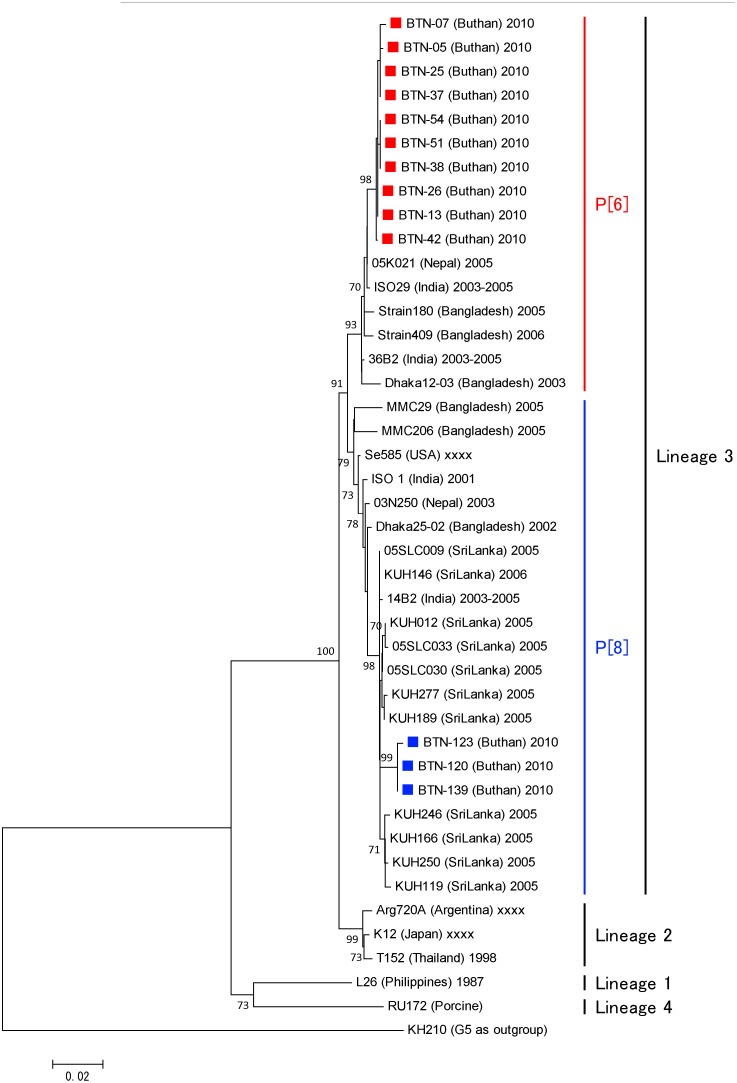
Phylogenetic tree constructed based on the deduced amino acid sequences of the VP7 gene of G12 strains.Bhutanese strains are indicated by black squares, which are followed by the strain numbers. Human rotavirus KH210 (G5) was used as an outgroup. The numbers adjacent to nodes represent the bootstrap values; values<70% are not shown. The scale bar shows the genetic distance, which is expressed as amino acid substitutions per site. The DNA Data Bank of Japan/European Molecular Biology Laboratory/GenBank accessions numbers are: AB905467 (rotavirus strain BTN-05), AB905468 (BTN-07), AB905469 (BTN-13), AB905470 (BTN-25), AB905471 (BTN-26), AB905472 (BTN-37), AB905473 (BTN-38), AB905474 (BTN-42), AB905475 (BTN-51), AB905476 (BTN-54), AB905477 (BTN-120), AB905478 (BTN-123), and AB905479 (BTN-139).